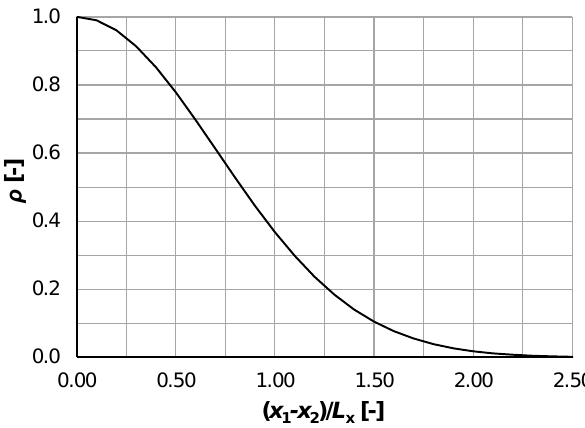
Figure 8. Quadratic exponential correlation function.